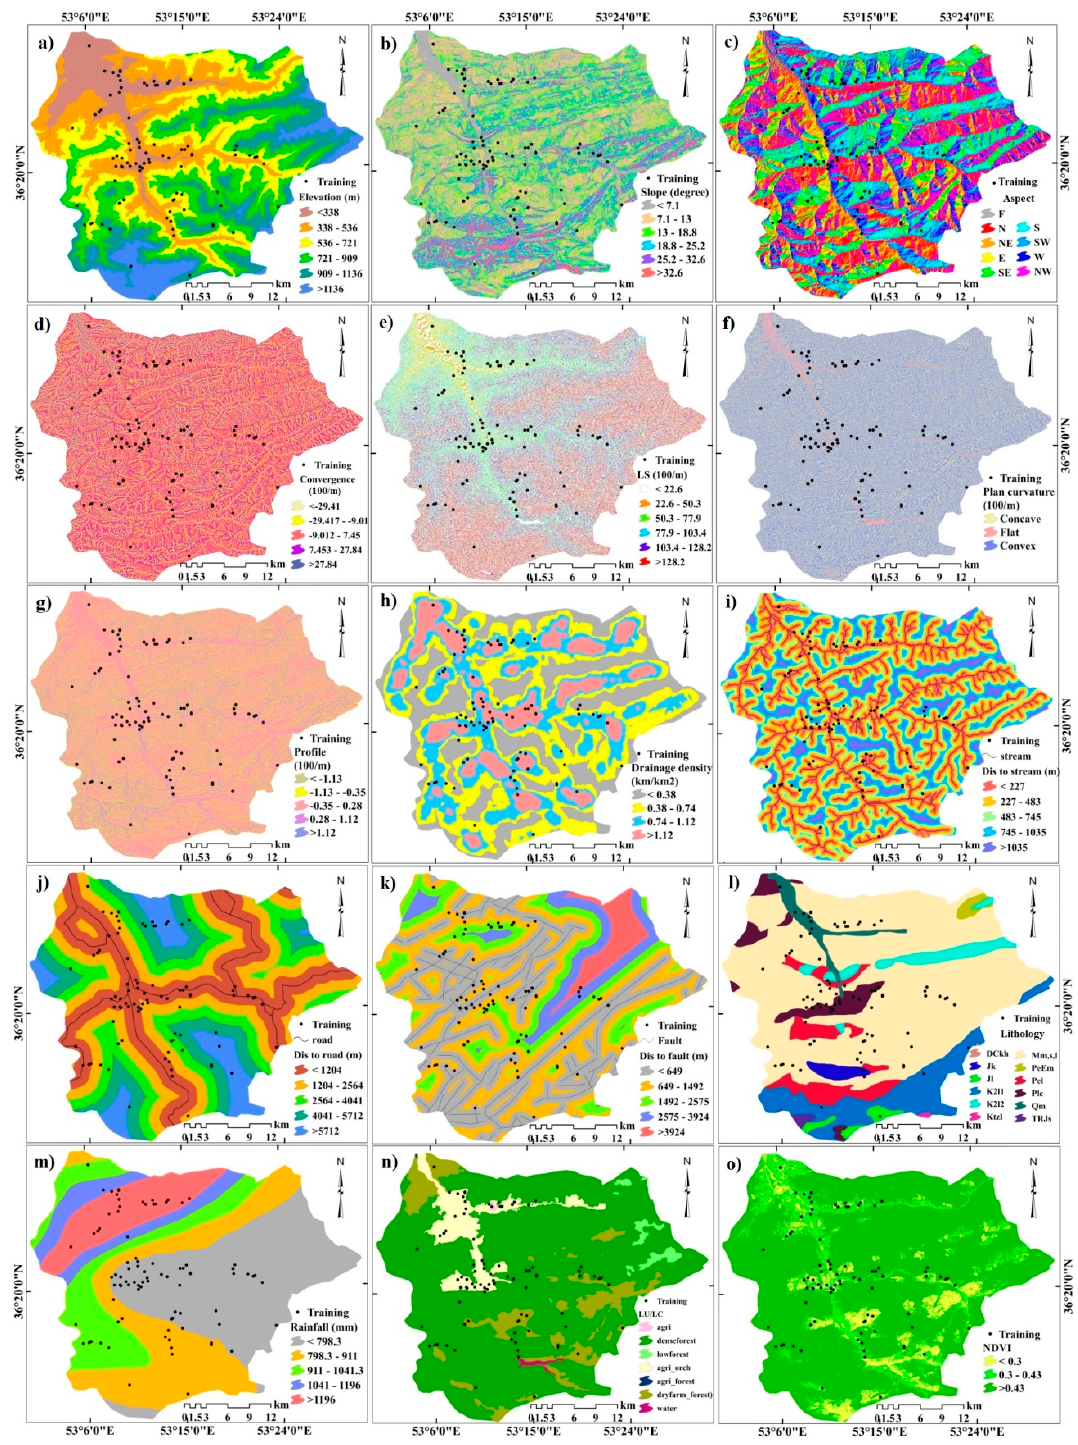
Figure 2. Landslide conditioning factors (LCFs): ( a ) elevation; ( b ) slope degree; ( c ) slope aspect; ( d ) convergence index; ( e ) slope length (SL); ( f ) plan curvature; ( g ) profile curvature; ( h ) drainage density; ( i ) distance to stream; ( j ) distance to road; ( k ) distance to fault; ( l ) lithology; ( m ) rainfall; ( n ) land use / land cover(LU / LC); ( o ) normalized di ff erence vegetation index